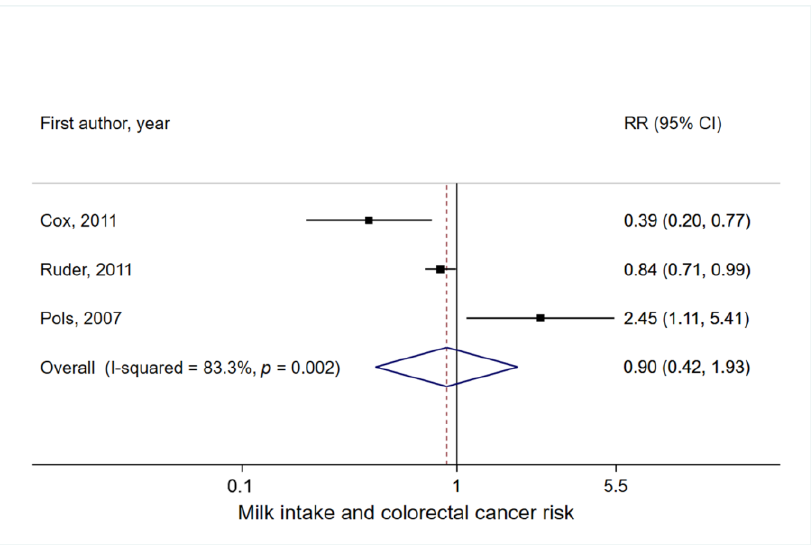
Figure 4. Meta-analysis of milk intake in early life with any colorectal cancer risk. For each study, the RR and corresponding 95% CI of individual studies are marked by the location of the black box and the width of the horizontal line, respectively. The size of the box indicates the weight that the RR receives when calculating the summary estimate. The summary RR and its 95% CI are represented by the center and weight of the diamond, respectively.